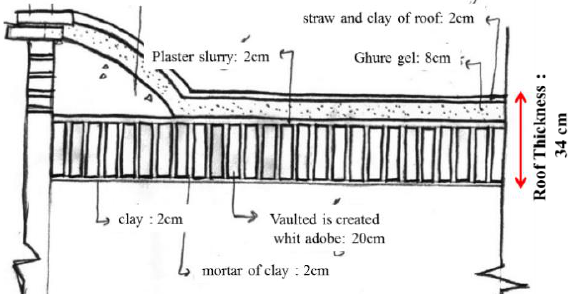
Figure 11. Thickness of roof covering and roofing layers.